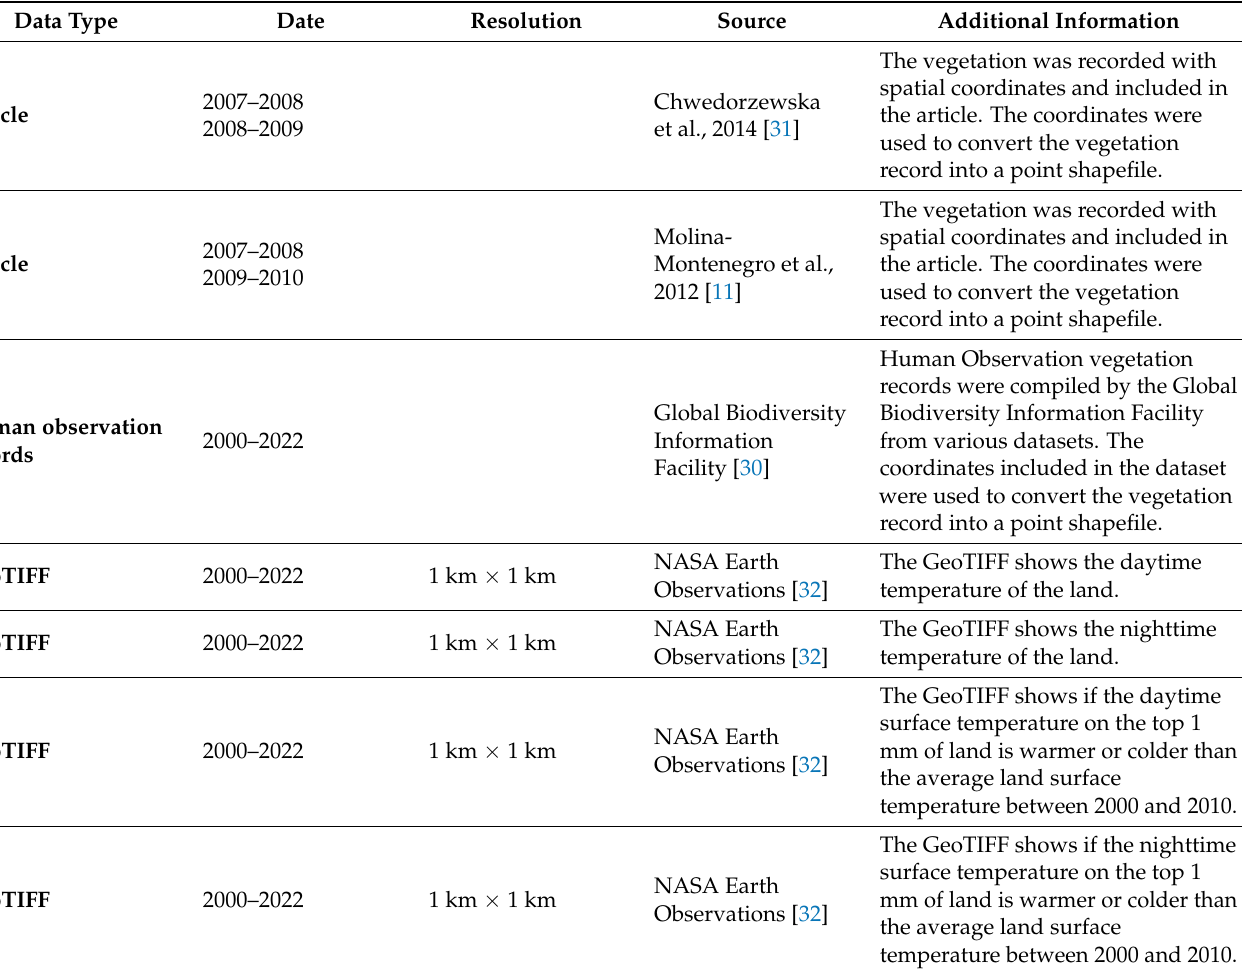
Table 1. Description of Data